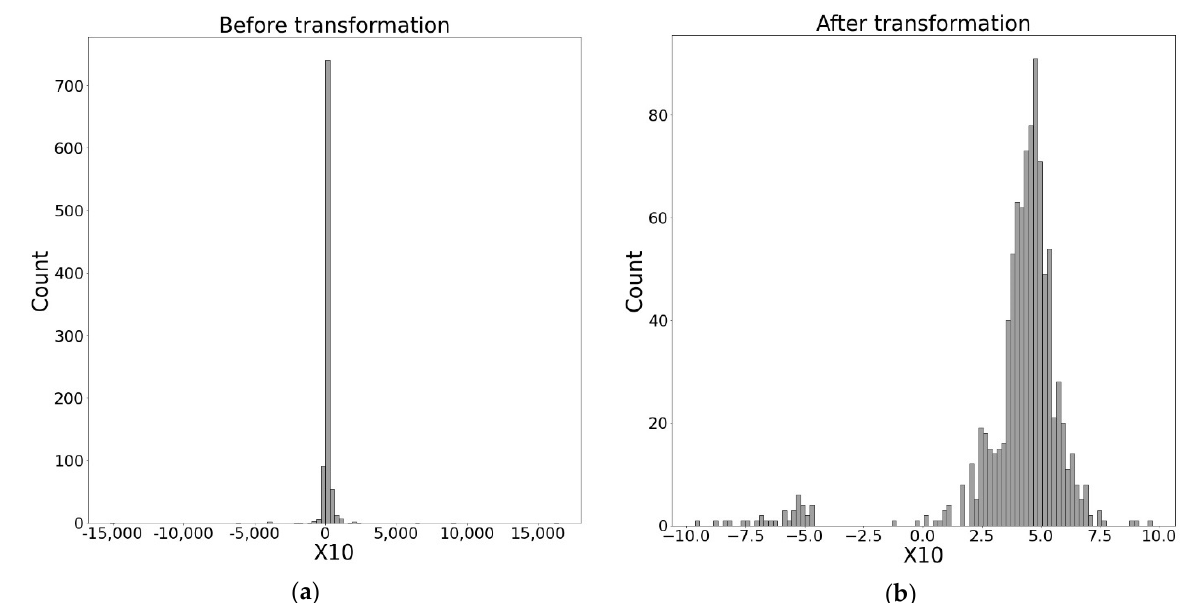
Figure 2. Histogram of the X10 variable before ( a ) and after ( b ) transformation according to Formula (1).